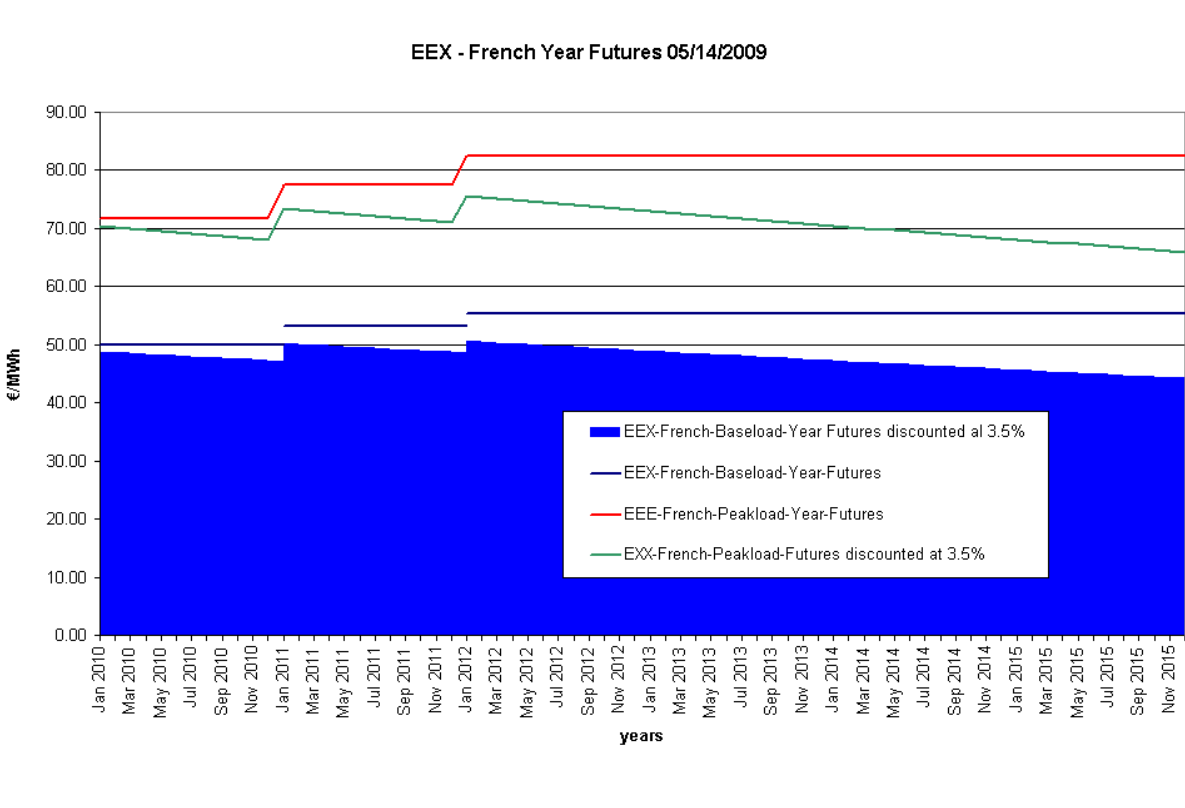
Figure 4. Futures prices of French electricity on EEX